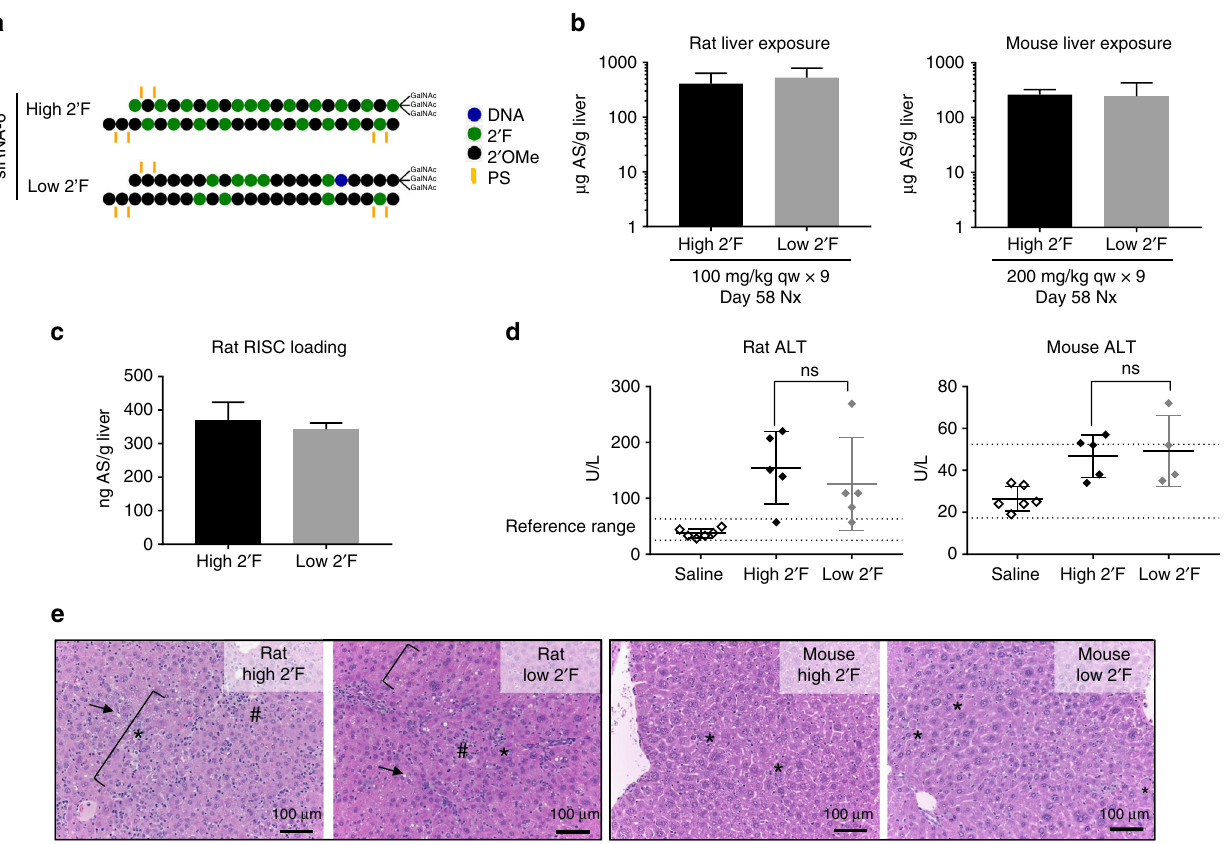
Fig. 2 Changing siRNA chemical modi fi cations does not mitigate hepatotoxicity. a Chemical modi fi cation patterns of the high 2 ′ F and low 2 ′ F GalNAc- siRNAs with the same PS content and sequence. b Liver exposures in rat and mouse toxicity studies as assessed by stem-loop RT-qPCR for the antisense strand (AS) at necropsy (nx). c Liver RISC loading as assessed by stem-loop RT-qPCR for the antisense at necropsy. d Serum alanine aminotransferase (ALT) levels measured at necropsy. Differences between group means were evaluated for statistical signi fi cance using one way ANOVA with post hoc corrections (for multiple siRNAs) in GraphPad Prism 7. ns, not signi fi cant. Error bars represent standard deviation of the mean. e H&E staining of liver sections collected at necropsy. In the rat, both high 2 ′ F and low 2 ′ F siRNA-6 compounds were associated with hepatocellular degeneration (bracket), single cell necrosis (*), increased sinusoidal cells consistent with Kupffer cell hyperplasia and/or in fi ltrating leukocytes (#), and hepatocellular vacuolation (arrow). In the mouse, fi ndings consisted of single-cell necrosis for both chemical modi fi cation patterns. All microscopic liver fi ndings are tabulated in Supplementary Table 4. N = 3 males (6 – 8 weeks old) per group; qw weekly